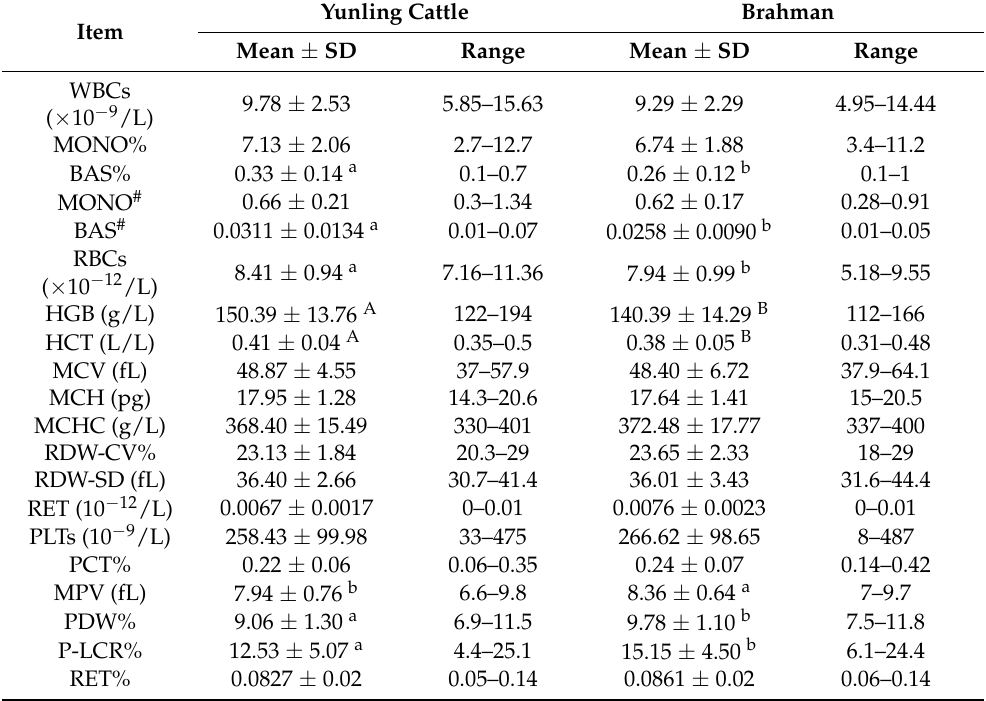
Table 1. The hematology indicators of Brahman and Yunling cattle.